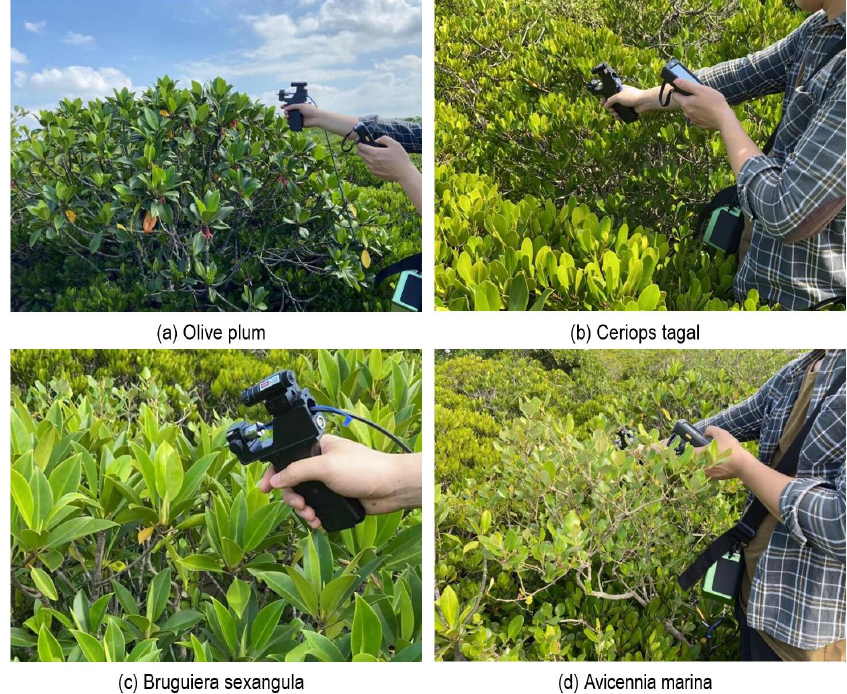
Figure 2. Typical spectral data acquisition process. Each branch has three consecutive scans of different angles, and the mean value is taken as the final reflectance spectrum of the branch leaves. The spectrum can be directly collected, and the optical fiber probe can be used to collect the spectral information at different canopy azimuth angles when the height of the plant is lower than the height of the operator. ( a ) Olive plum; ( b ) Ceriops tagal; ( c ) Bruguiera sexangula; ( d ) Avicennia marina.